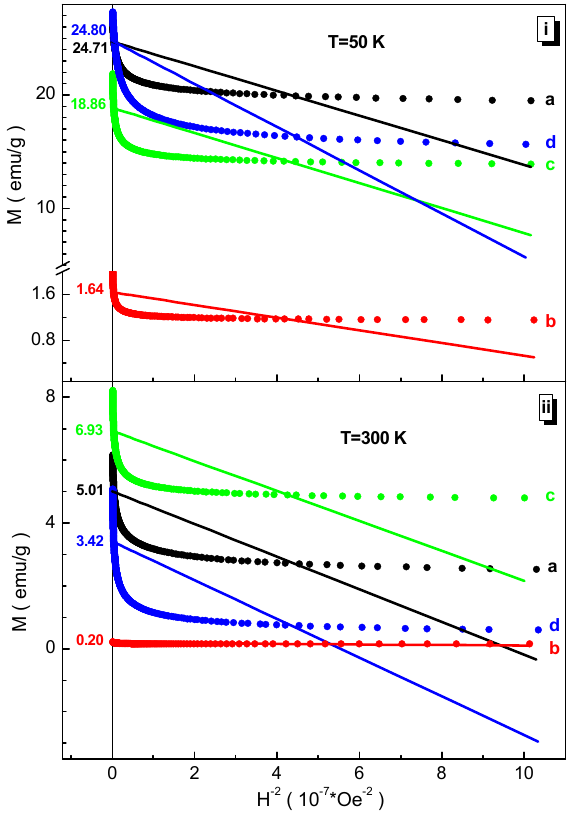
Figure 6. Dependencies of magnetization vs. inverse field square and their linear extrapolations at 50 K ( i ) and 300 K ( ii ) for the compositions ( a ) BaFe 5.84 Ga 6.16 O 19 , ( b ) BaFe 6.26 Al 2.27 Cr 3.47 O 19 , ( c ) BaFe 6.11 Al 1.56 Cr 2.17 Ga 2.16 O 19 , ( d ) BaFe 6.19 Al 1.25 Cr 1.57 Ga 1.74 In 1.26 O 19 . BaFe 6.11 Al 1.56 Cr 2.17 Ga 2.16 O 19 , (d) BaFe 6.19 Al 1.25 Cr 1.57 Ga 1.74 In 1.26 O 19